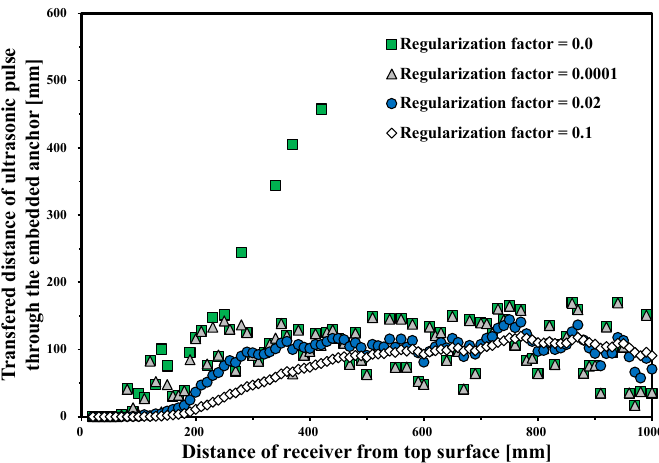
Figure 8. Effect of the regularization factor on the transferred distance of the ultrasonic pulse through the embedded anchor bolt.